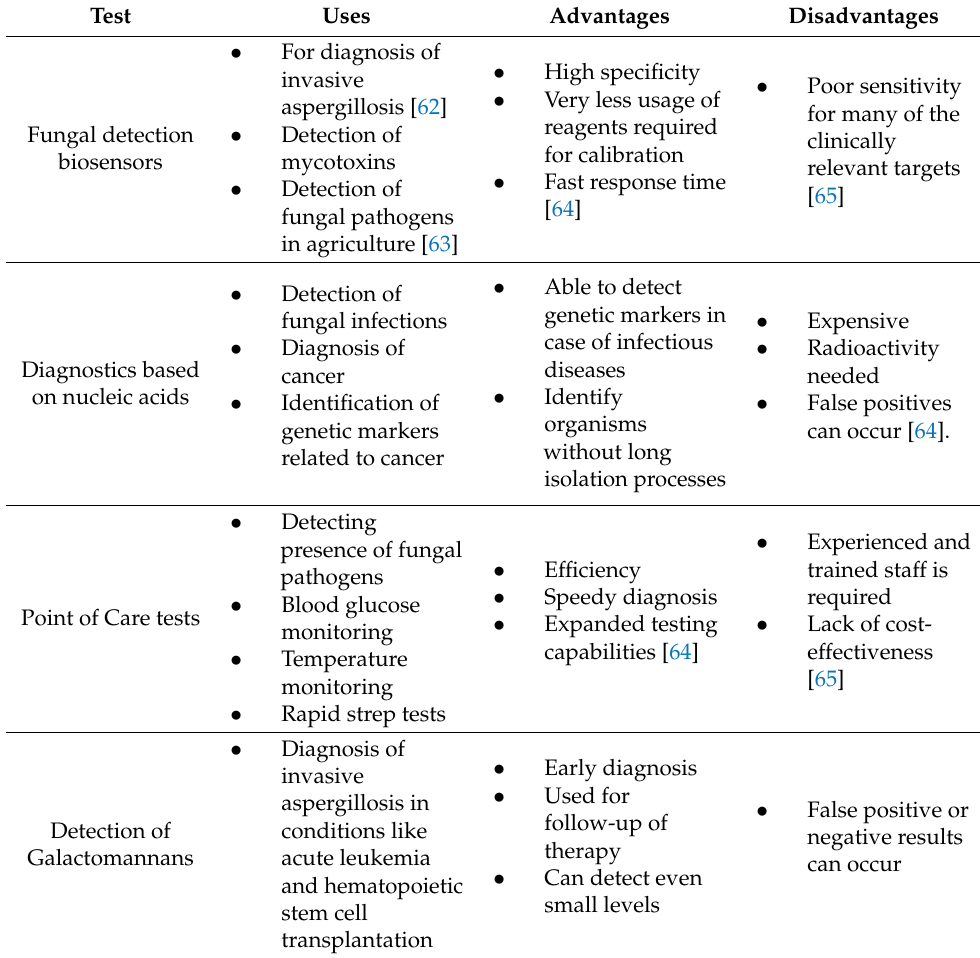
Table 1. An overview on the different types of nanotechnology based diagnostic